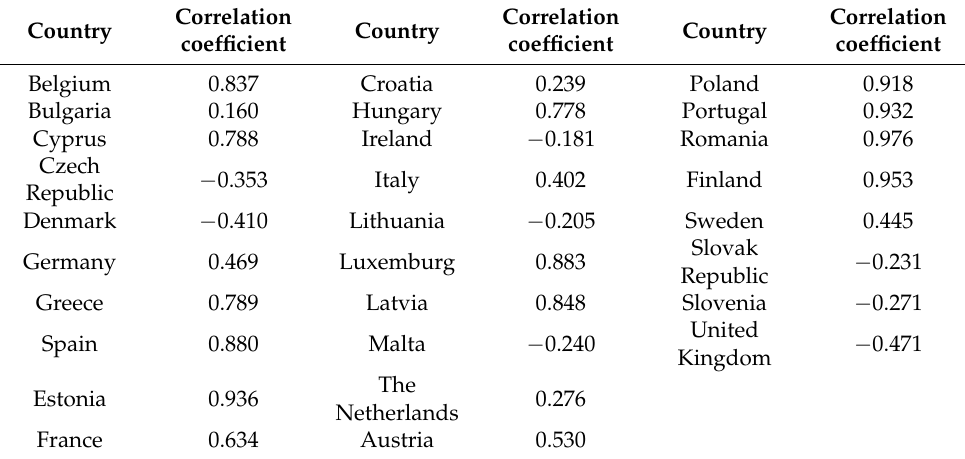
Table 5. Correlation analysis between the size of the enterprise and the tax burden of the EU member states. Correlation Correlation Correlation Country Country Country coefficient coefficient coefficient Belgium 0.837 Croatia 0.239 Poland 0.918